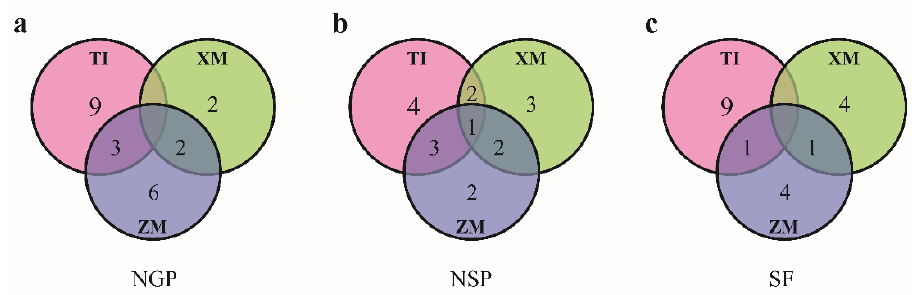
Figure3. NumberofQTLsdetectedinthreeRILpopulationsforNGP( a ), NSP( b )andSF( c Figure 3. Number of QTLs detected in three RIL populations for NGP ( a ), NSP ( b ) and SF ( c ), respectively.